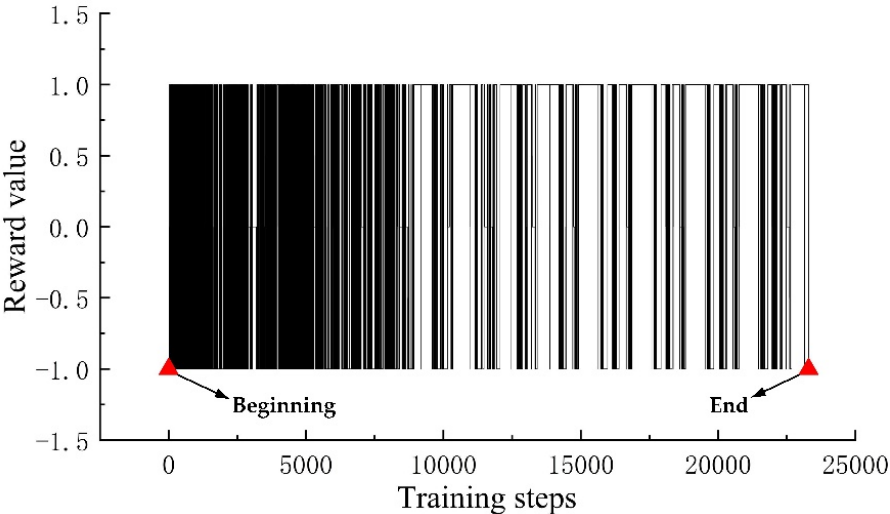
Figure 11. Agent training single-step rewards.